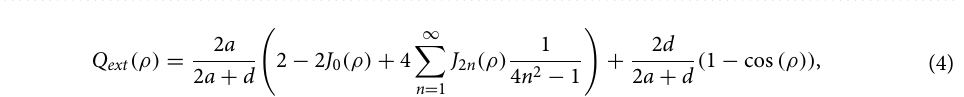
where a and d are the radius of the stadium’s end caps and the lengths of the straight sections as indicated in Fig. 1d, and ρ is the same as described above. In Fig. 3b, we compare the results of Eq. (4) with electromagnetic COMSOL Multiphysics simulations. The figure shows that both the van de Hulst formula in Eq. (4) and the COMSOL Multiphysics simulations predict that for a stadium, the positions of the wiggles are shifted to the right as d increases. This is explained in the following way. According to Eq. (4), the Bessel term dominates for small d , while for large d the cosine term dominates. The Bessel term, i.e., Q ext for a sphere, is illustrated as the red, dashed line in Fig. 3a, while the the function 2 ( 1 − cos (ρ)) , essentially the cosine term in Eq. (4), is illustrated as the yellow, dash-dotted line in Fig. 3a. Fig. 3a shows that the cosine term is shifted to the right with respect to the Bessel term. Thus, because